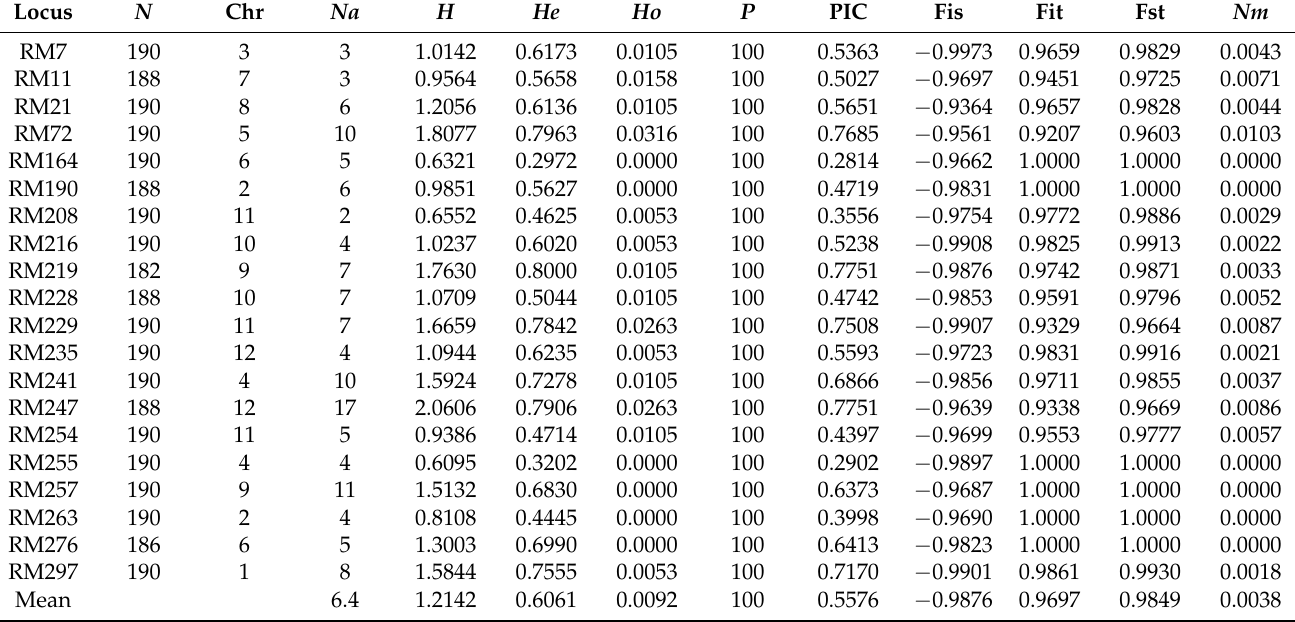
Table 1. Results of the genetic diversity analysis of 95